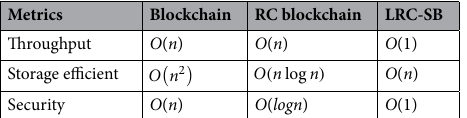
Table 3. Comparison of performance and efficiency of three kinds of